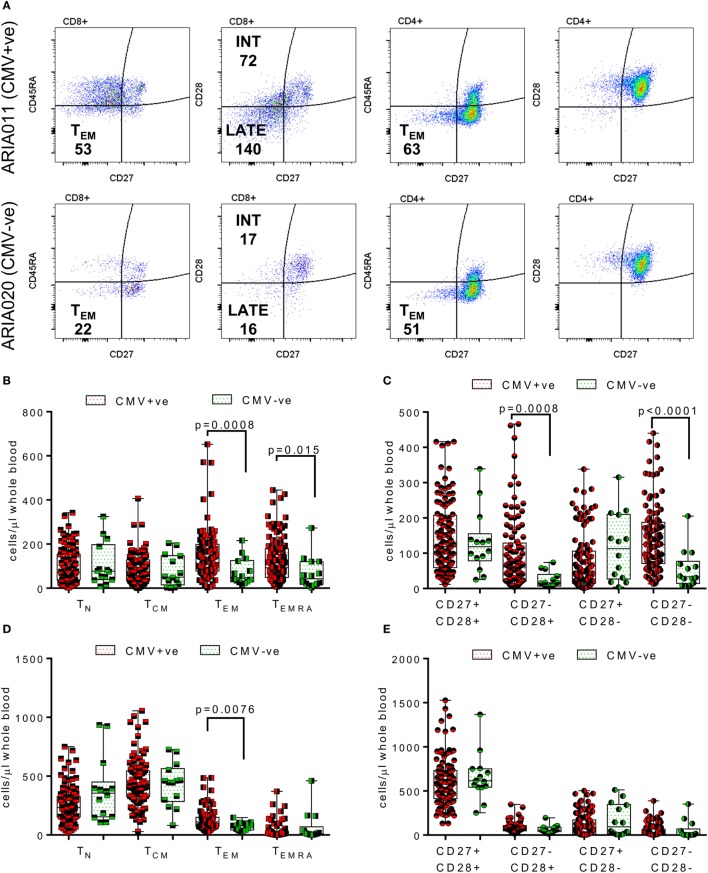
Impact of human cytomegalovirus (HCMV) carriage on T cell numbers. EDTA treated whole blood was stained with a panel of phenotyping antibodies in order to enumerate CD4+ and CD8+ T cells and their subsets. Representative dot plots from a HCMV seropositive (HCMV +ve) and HCMV seronegative (HCMV-ve) age-matched donors are illustrated showing the memory (as defined by CD27 and CD45RA expression) and differentiation level (as defined by CD27 and CD28) phenotype of both CD4+ and CD8+ T cells; the number of cells per microliter of whole blood for effector memory (TEM—CD27−CD45RA−) CD4+ and CD8+ T cells and Intermediate (INT—CD27−CD28+) and Late (LATE—CD27−CD28−) differentiated CD8+ T cells are shown (A). Box and whisker plots comparing cell numbers of the memory (B,D) and differentiation phenotypes (C,E) of CD8+ T cells and CD4+ T cells, respectively, between HCMV +ve (red) and HCMV-ve (green) donors are shown. The differences between the two groups were analyzed by a Kruskal–Wallis one-way ANOVA test with post hoc Mann–Whitney U-test performed with significant results set as p ≤ 0.015 shown on each graph. A representative CD4 vs CD8 dot plot from the same donors with their respective CD4:CD8 ratio indicated are shown (F), the comparison of CD4:CD8 ratios for all seropositive vs seronegative donors are also shown (G) with the significant decrease in the CD4:CD8 ratio in HCMV positive donors indicated (Mann–Whitney test).